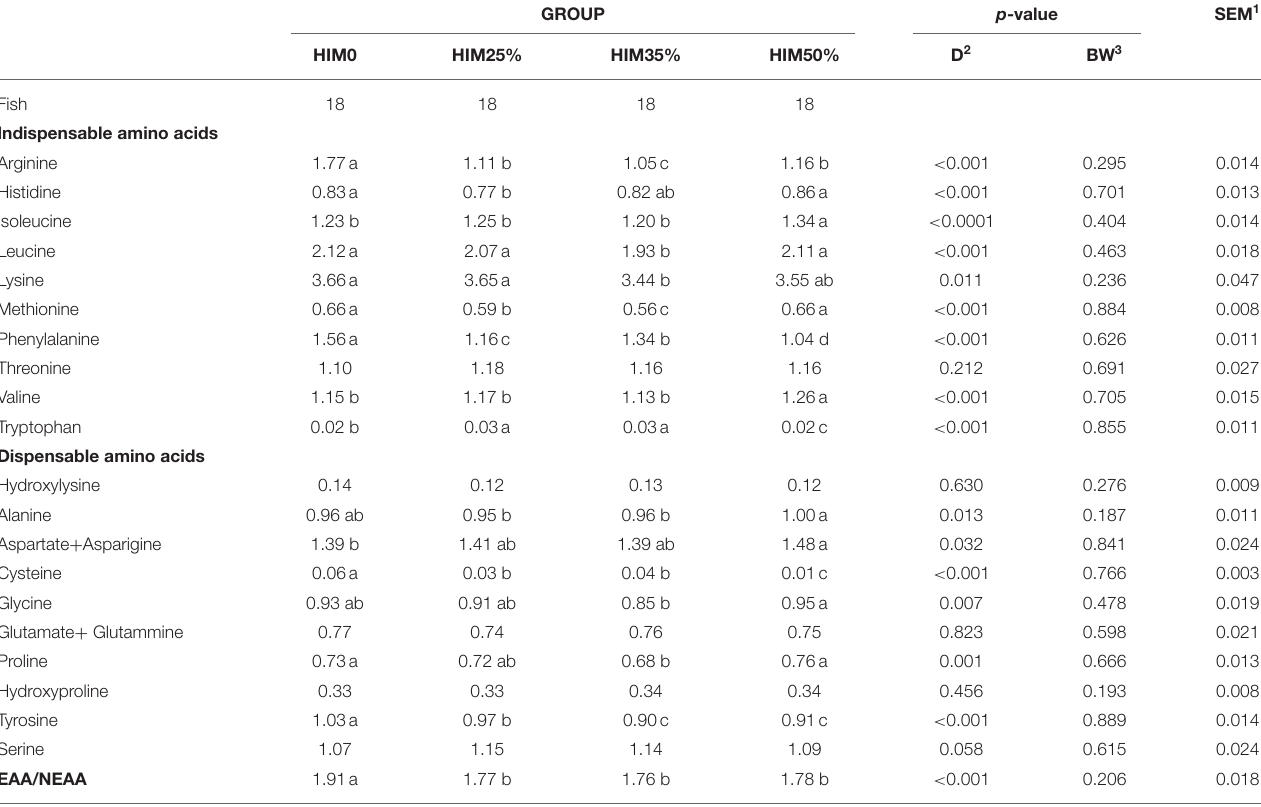
TABLE 7 | Amino acid composition (g/100g of wet weight) of the filets of the gilthead sea bream fed with the four exerimental diets. GROUP p -value SEM